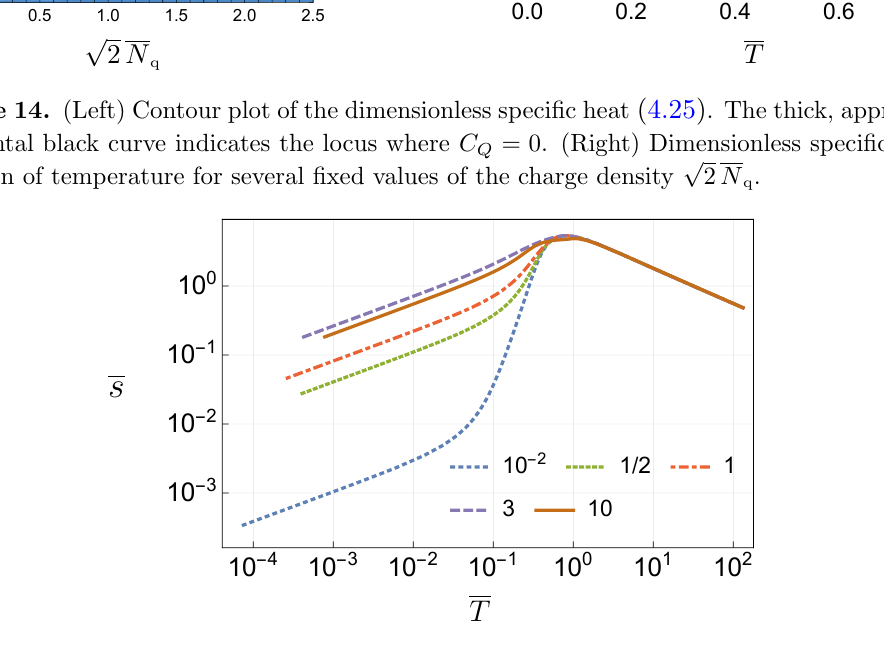
Figure 15. Entropy density as a function of temperature for various values of the charge p density 2 N q